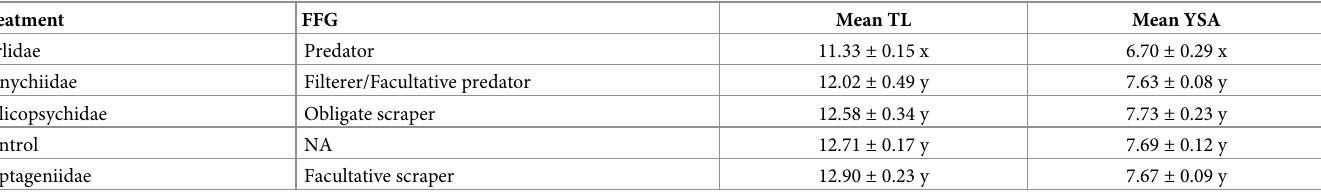
Values in the TL and YSA columns with identical lower-case letters are not significantly different (Dunn’s Test: p-adjusted Bonferroni < 0.05). “NA” indicates the absence of insects